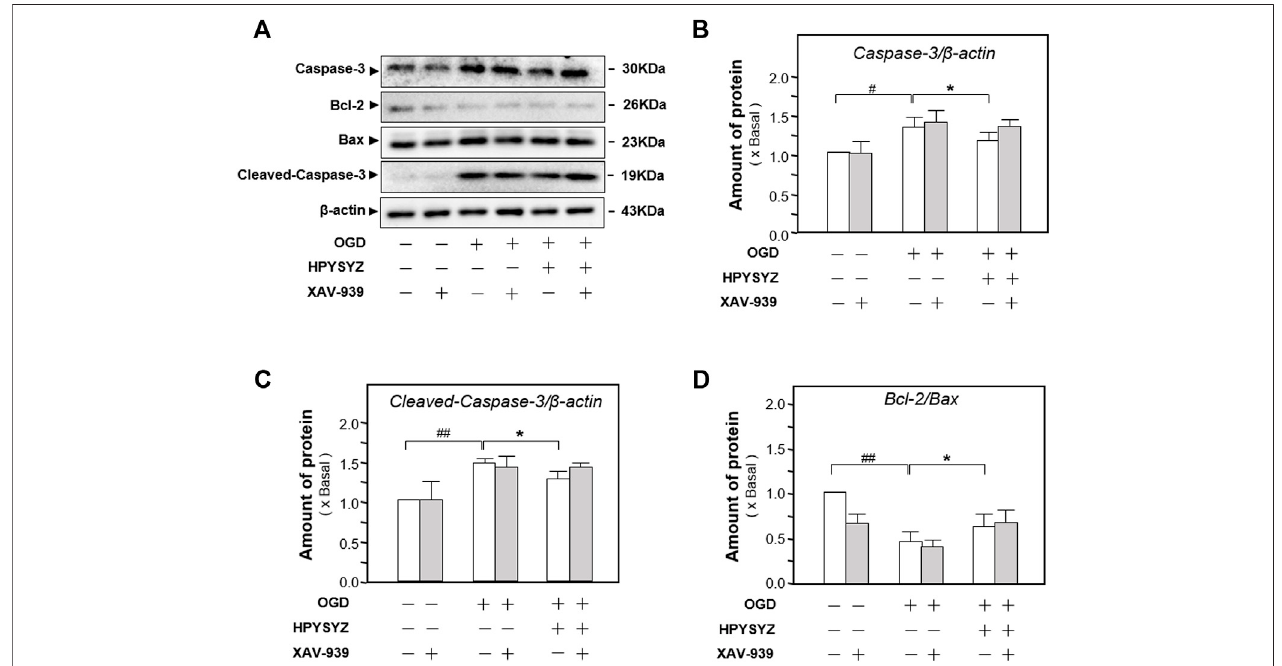
FIGURE 12 | Effect of co-treatment of ethyl acetate extracts of succinum and XAV-939 on regulating the caspase-dependent pathway of HT22 cells under OGD condition. (A) Effect of ethyl acetate extracts of succinum (HPYSYZ) on the expressions of caspase-3, Bcl-2, Bax, and β -actin of HT22 cells under OGD condition after the co-treatment of XAV-939 was evaluated by Western blotting analysis. The representative images are displayed ( n = 5). (B) Expression ratio of caspase-3 to β -actin was calculated, and the expression of β -actin was applied for normalization. (C) The expression ratio of Cleaved-Caspase 3 to β -actin was calculated and the expression of β -actin was applied for normalization. (D) Expression ratio of Bcl-2 to Bax was calculated, and the expression of β -actin was applied for normalization. Values are expressed as mean ± SEM ( n = 5). Comparisons between groups were carried out by a one-way ANOVA followed by a post hoc Bonferroni test. ## p < 0.01, * p < 0.05, and ** p <